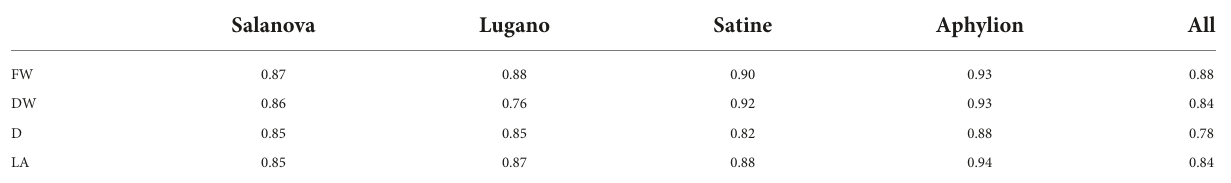
TABLE 3 Correlation between H and other traits of different lettuce varieties. Traits